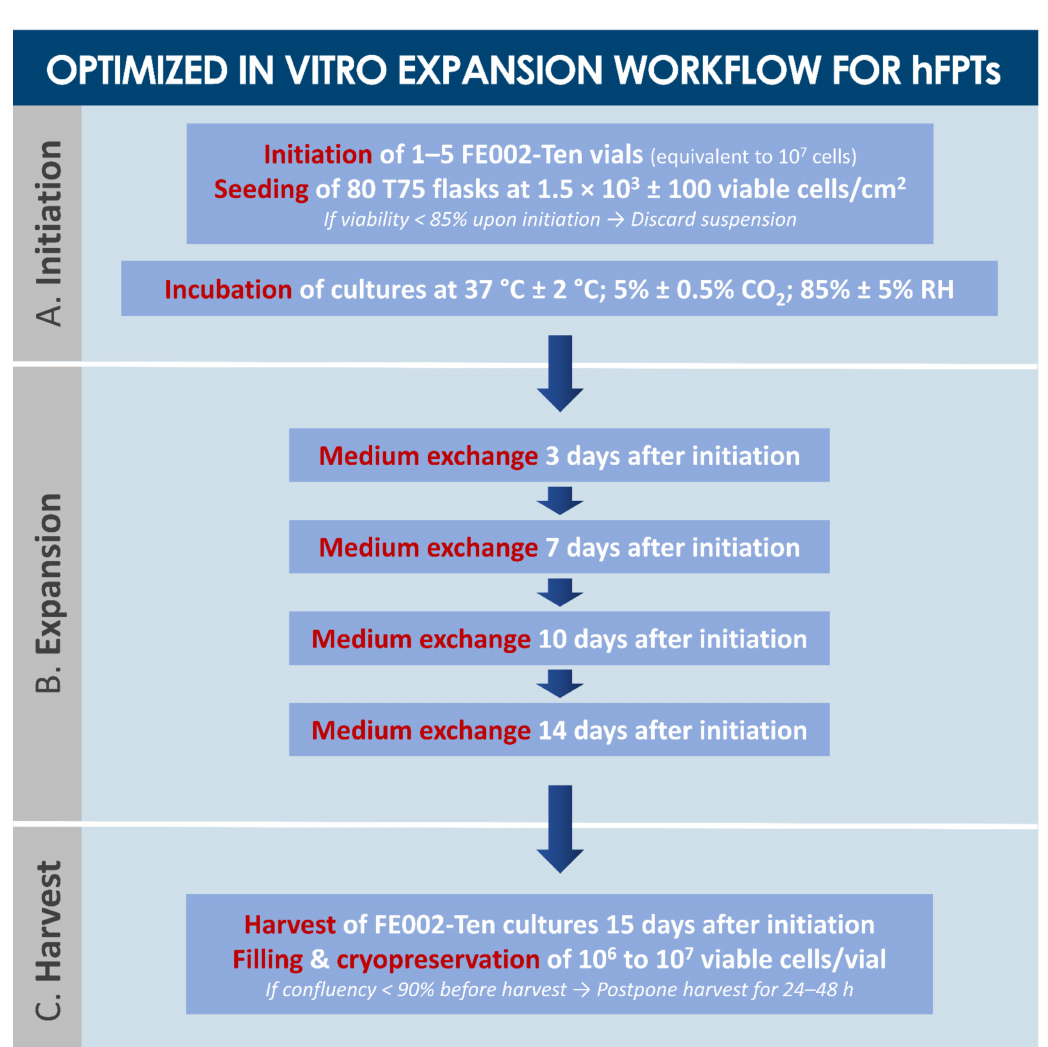
Figure 2. Optimized in vitro expansion workflow for large-scale banking of FE002-Ten hFPTs. Multiple optimization steps and parameter validation (i.e., cell seeding densities, culture periods, choice of serum source and culture surface type) enabled the selection of adapted culture conditions and related technical specifications for maximization of manufacturing efficiency of homogenous materials. The presented workflow was applicable for Passages 1 to 8, which are of interest for clinical applications (i.e., higher passages were characterized by longer PDTs and required an additional medium exchange step). Complete culture medium was composed of Dulbecco’s Modified Eagle Medium, supplemented with 10% v/v FBS and L-glutamine. Cryopreservation medium was composed of 50% v/v complete medium, 40% v/v FBS, and 10% v/v DMSO. Optimal proliferation conditions were obtained with a clinical-grade Sigma ® FBS lot, using 75 cm 2 culture flasks, cell seeding at 1.5 × 10 3 ± 100 viable cells/cm 2 ( A ), culture medium volumes of 10 mL/flask, culture medium exchanges twice/week ( B ), and 14–15 days of culture before harvest ( C ). DMSO, dimethyl sulfoxide; FBS, fetal bovine serum; hFPT, human fetal progenitor tenocytes; PDT, population doubling time; RH, relative